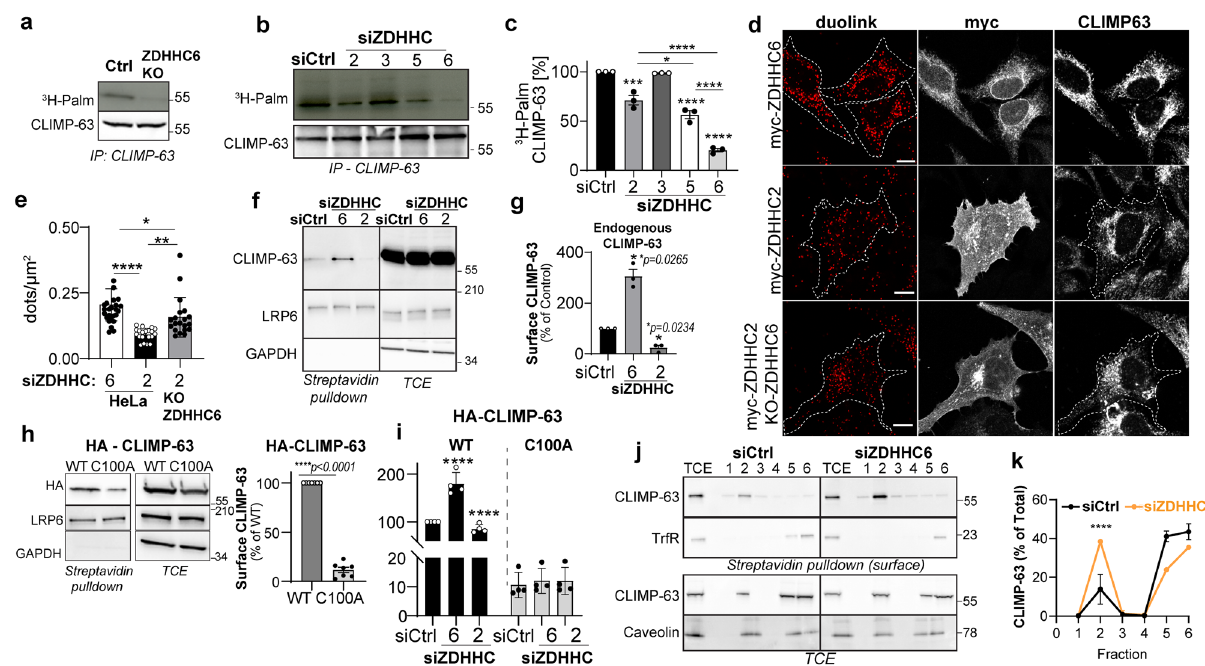
Fig. 2 | ZDHHC6 palmitoylates CLIMP-63and retains it attheER.a 3 H-palmitate labelling of CLIMP-63 immunoprecipitation fractions (IP) from control (Ctrl) or ZDHHC6 KO HeLa cells analysed by autoradiography and Western blot. b Same as in a but with HeLacellstransfected with control, siZDHHC2, siZDHHC3,siZDHHC5 or siZDHHC6. c Quanti fi cation of CLIMP-63 3 H-palmitate in b . ( n =4). d Proximity ligation assay (duolink) probing endogenous CLIMP-63 in HeLa cells expressing myc-ZDHHC2 or myc-ZDHHC6, or in ZDHHC6 KO cells expressing myc-ZDHHC2. Scalebars:10 μ m. e Quanti fi cationofresultsin d ,asduolink-dotspercellarea( μ m 2 ) for 15 cells for each condition. f Western blot of surface biotinylated proteins and total cell extracts (TCE) from HeLa cells transfected with control, siZDHHC6 or siZDHHC2. LRP6 and GAPDH are positive and negative controls, respectively. g Quanti fi cationofsurfaceCLIMP-63in f ( n =3). h Analysisofsurfaceproteinsasin f fromshCLIMP-63cellstransfected withHA-CLIMP-63WTorC100A.( n =7) i same